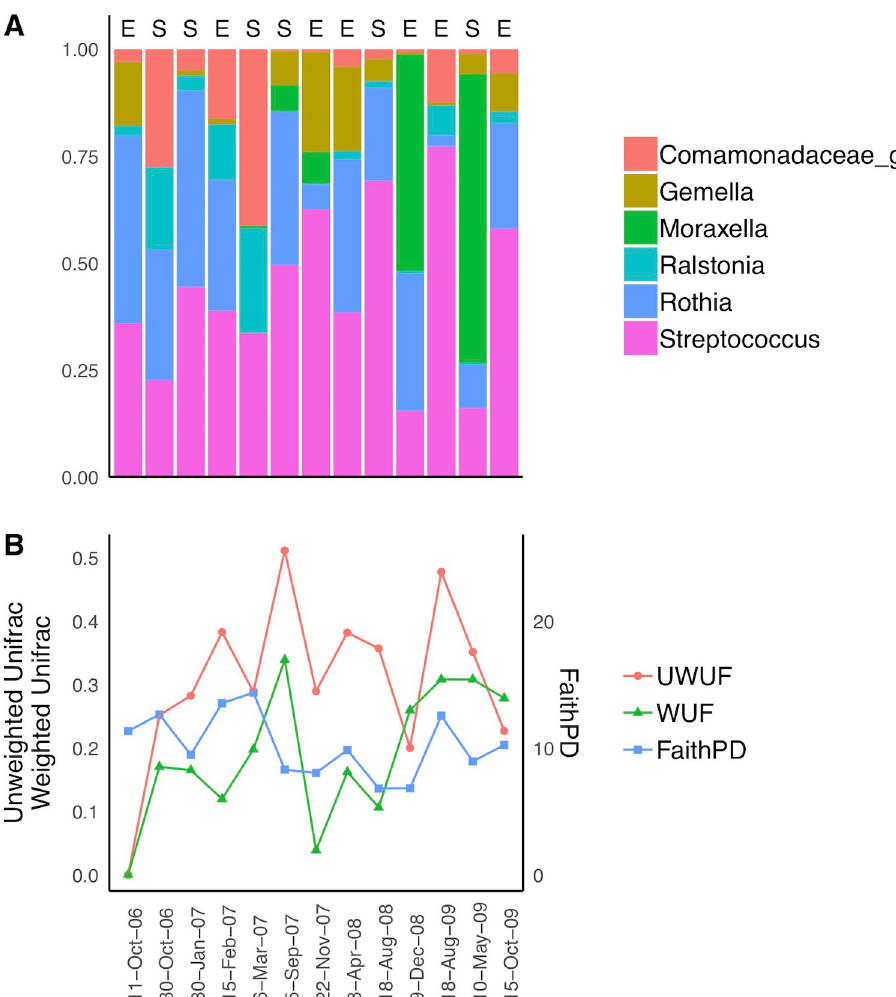
Fig 9. Taxonomic composition and diversity in 13 induced sputum samples collected from the same patient (chronic obstructive pulmonary disease) at different consultations. A: Presenting taxonomic composition at level 6 taxonomy (genus), provided by Silva database for amplicon sequence variants containing at least 1% of all sequences. Numbers are given as relative abundances per sample. B: Phylogenetic alpha- and beta-diversity. Alpha-diversity measured by Faith phylogenetic diversity (right y-axis). Non-quantitative and quantitative beta-diversity measured by UniFrac (UWUF, WUF respectively, left y-axis). Except from the first sampling time point beta diversity is calculated between consecutive samples. A+B: Disease state given in A by S = Stable state, E = Exacerbations. Samples are ordered chronologically and collection dates are given in B.